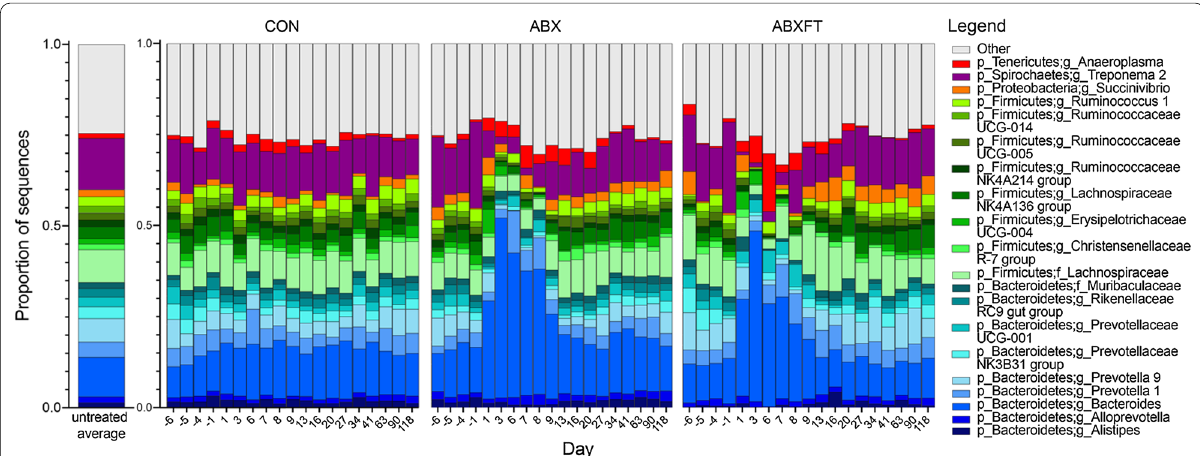
Fig. 1 Mean relative abundances of bacterial genera over time in the gut microbiomes of three experimental groups of male ring‑tailed lemurs ( Lemur catta ). Shown are values for healthy animals that received no treatment (CON), antibiotics only (ABX), or antibiotics plus fecal transfaunation (ABXFT). Genera are identified by color; those representing < 1% of the microbiomes were combined into the category “Other”. The x axis shows day relative to three phases of study: pretreatment (days ‑6 to ‑1), treatment (days 0–6/7), and recovery (days 7/8–118)